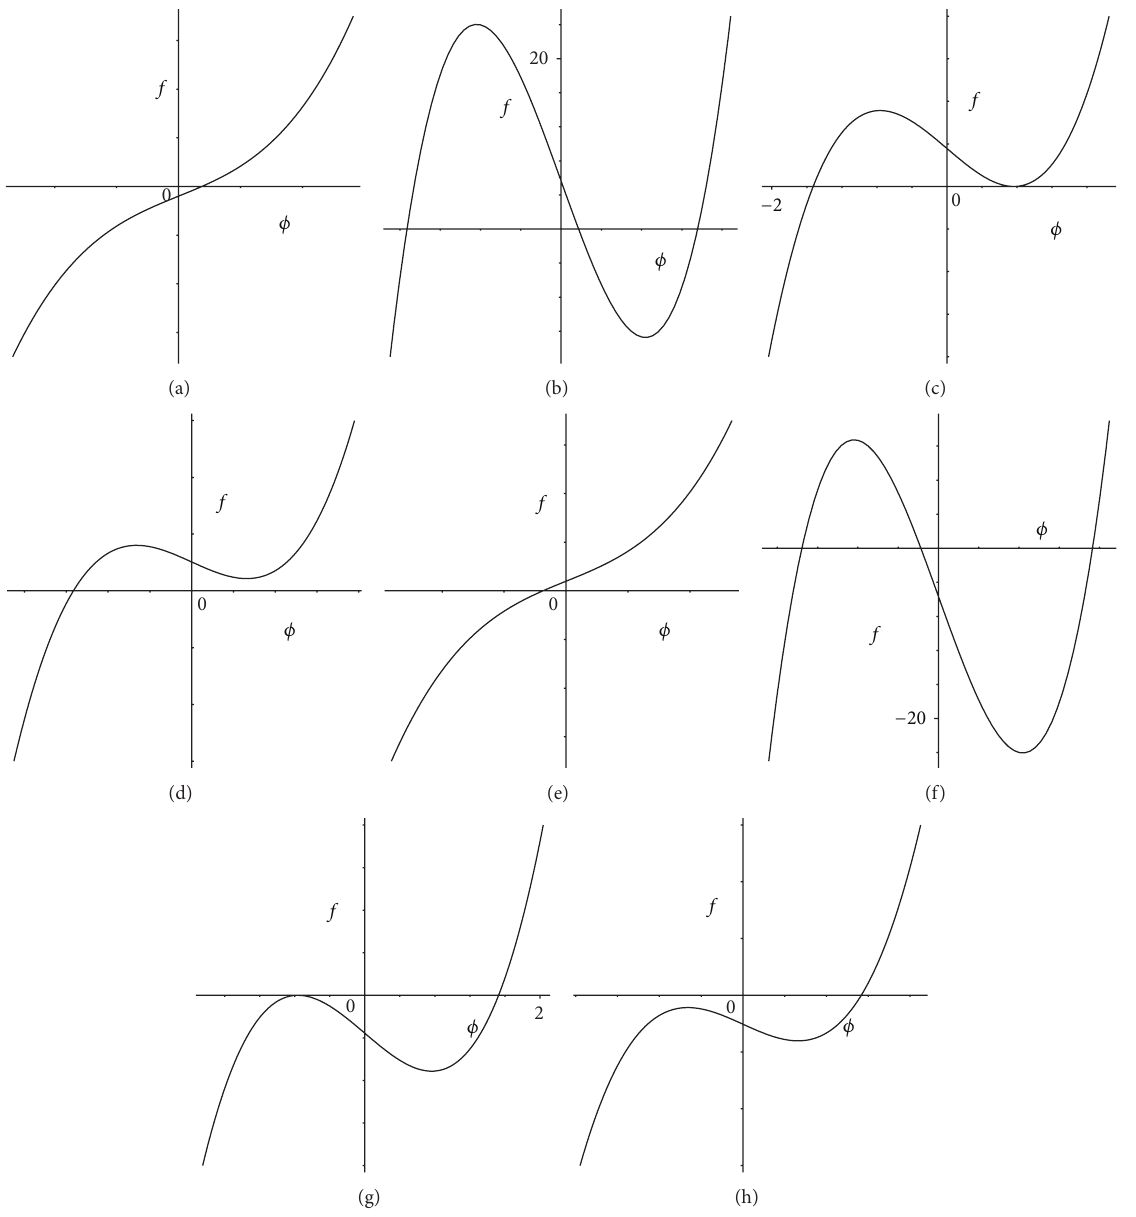
Figure 1: The graphics of the function 𝑓(𝜙) when 𝑐 ̸= 0 . (a) 𝑐 < 0 , 𝑘 < 0 . (b) 𝑐 < 0 , 0 < 𝑘 < 𝑘 ∗ . (c) 𝑐 < 0 , 𝑘 = 𝑘 ∗ . (d): 𝑐 < 0 , 𝑘 > 𝑘 ∗ . (e) 𝑐 > 0 , 𝑐 > 0 , 𝑘 = 𝑘 𝑐 > 0 , 𝑘 > 𝑘 𝑘 < 0 . (f) 𝑐 > 0 , 0 < 𝑘 < 𝑘 ∗ . (g) ∗ . (h) ∗